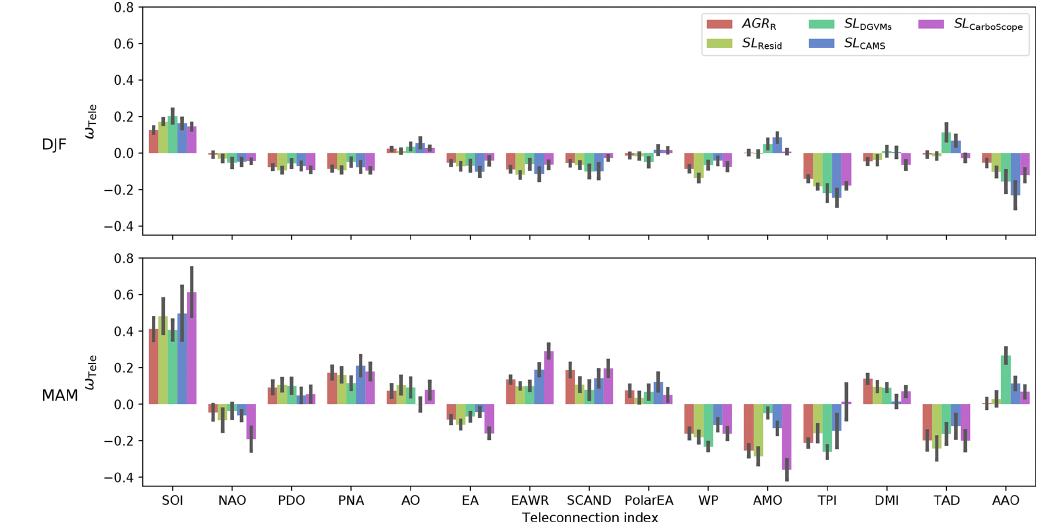
Figure A5. Distribution of ω Tele with the time series of AGR R , SL Resid , SL DGVMs , SL CAMS , and SL CarboScope based on teleconnection indices in the period of 1980–2017.